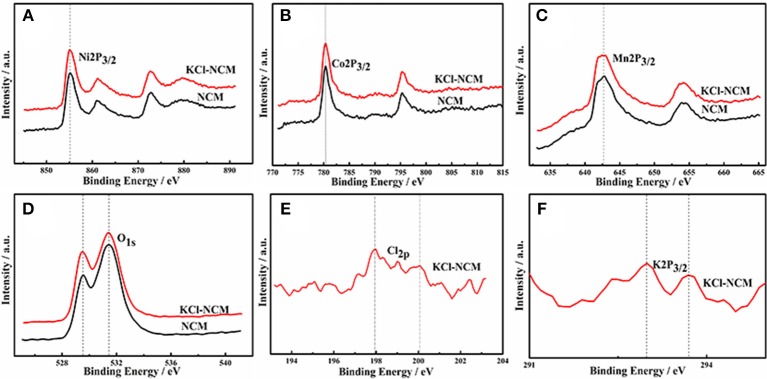
XPS images of NCM and NCM-KCl. (A) Ni2p3/2; (B) Co2p3/2; (C) Mn2p3/2; (D) O1s; (E) Cl2p; (F) K2P3/2.